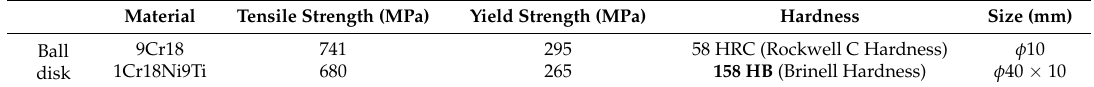
Table 1. Parameters of the pin ‐ on ‐ disk and ball ‐ on ‐ disk configurations. Table 2. Material chemical composition of the ball-on-disk configurations (weight%).